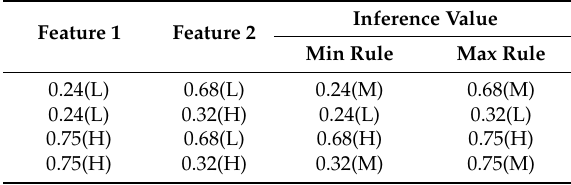
Table 4. An example of the Inference Value produced by Min and Max rules with fuzzy rule table of Table